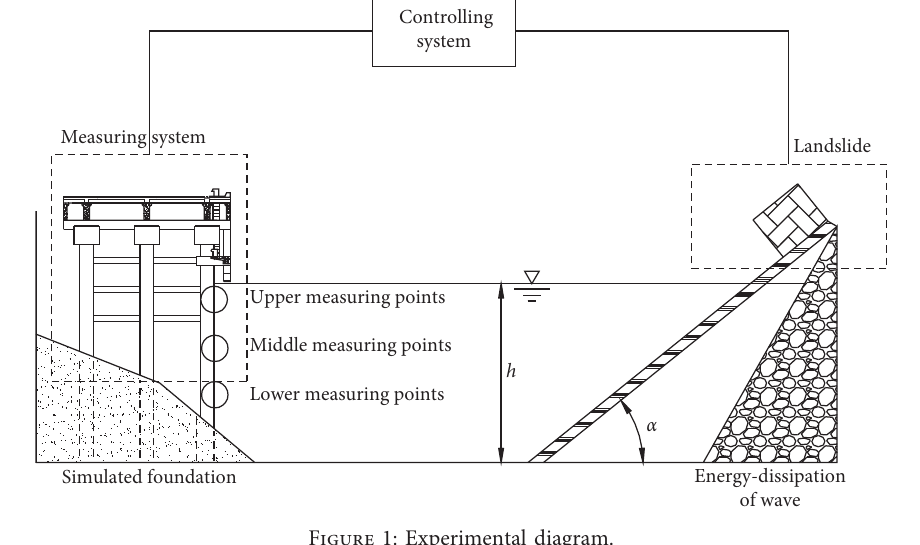
Figure 1: Experimental diagram.